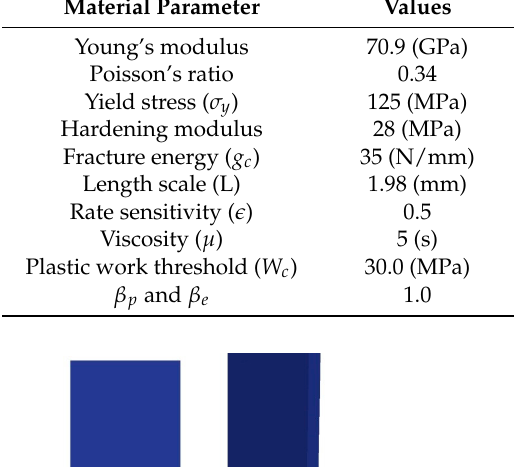
Figure 11. Sample geometry and boundary conditions.